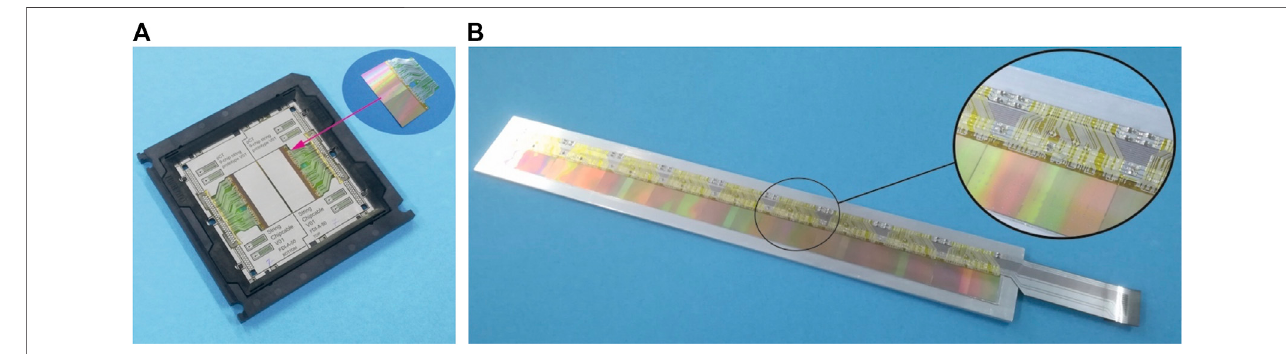
FIGURE7|(A) ThechipcableembeddedonaplasticframewithtwoALICEpixeldetectors(ALPIDE)mountedonit. (B) ApCTstringcontainingnineALPIDEchips.